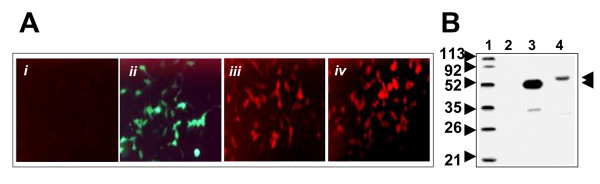
rAd-mediated expression of rEDIII-4/2 protein as aGFP fusion. (A) Detection of rAd-mediated bivalent antigen expression by fluorescence microscopy. HEK 293 cells were either infected with rAd-C (panel i), or rAd-Bg (panel ii-iv) for 24 hours and examined either directly for GFP fluorescence (panels i and ii) or analyzed by IFA, using either mAb 3H5 (panel iii) or MAB8704 (panel iv), as the primary antibody in conjunction with rhodamine-conjugated anti-murine IgG as the secondary antibody. (B) Immunoprecipitation of the bivalent protein from infected HEK 293 cells. Cells were infected with rAd-C (lane 2), a rAd expressing DEN-2 E (lane 3 [ref. 45]) or rAd-Bg (lane 4) viruses. Infected cells were metabolically labeled with [35S]-methionine, lysed, immunoprecipitated with 3H5 mAb, and analyzed on a denaturing 15% polyacrylamide gel. Pre-stained protein markers were run on the same gel (lane 1); their sizes (in kDa) are indicated on the left. The arrows on the right show the positions of the bivalent protein (upper) and the E protein (lower).